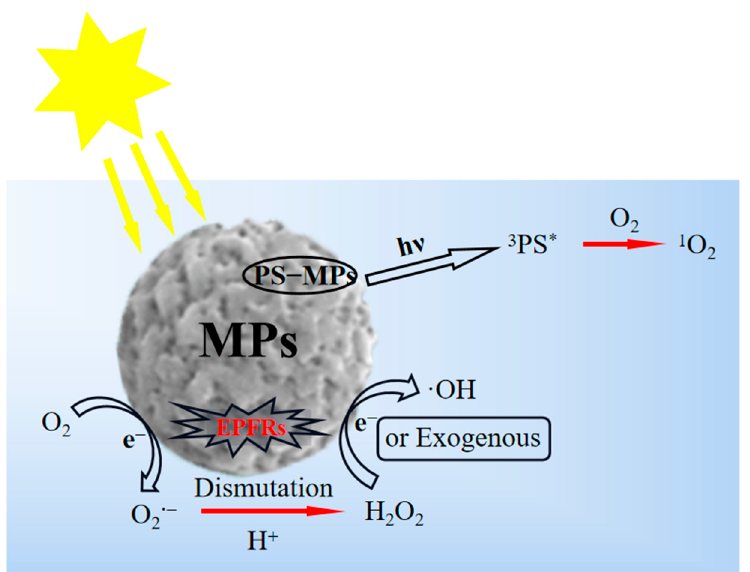
Figure 4. Proposed mechanism of MPs serving as photosensitizers for the formation of ROS in the presence of light.